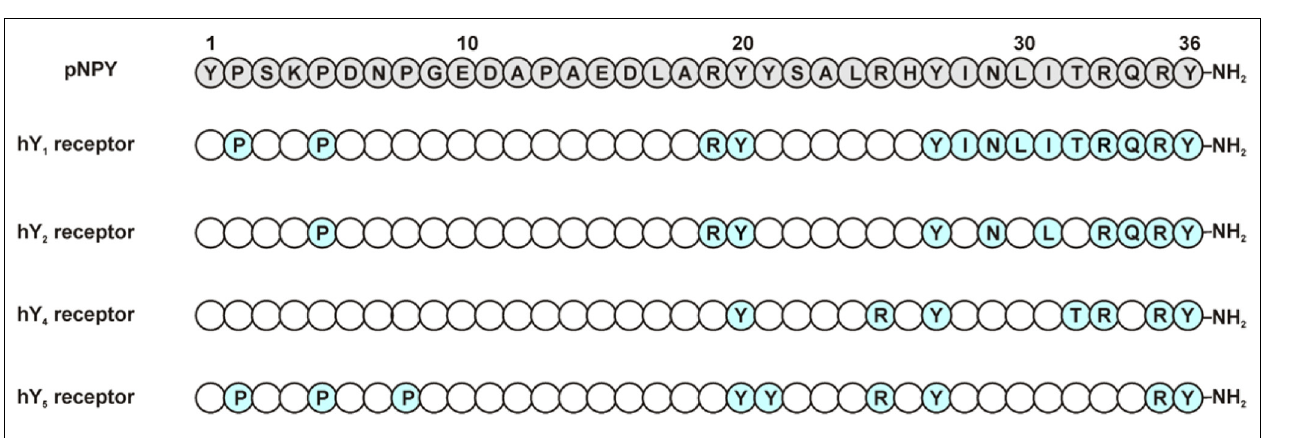
FIGURE 3 | Relevant amino acids in pNPYAla-scan at NPY receptors. Positions in blue represent the amino acids showing a high impact when exchanged to Ala (Beck-Sickinger etal., 1994).